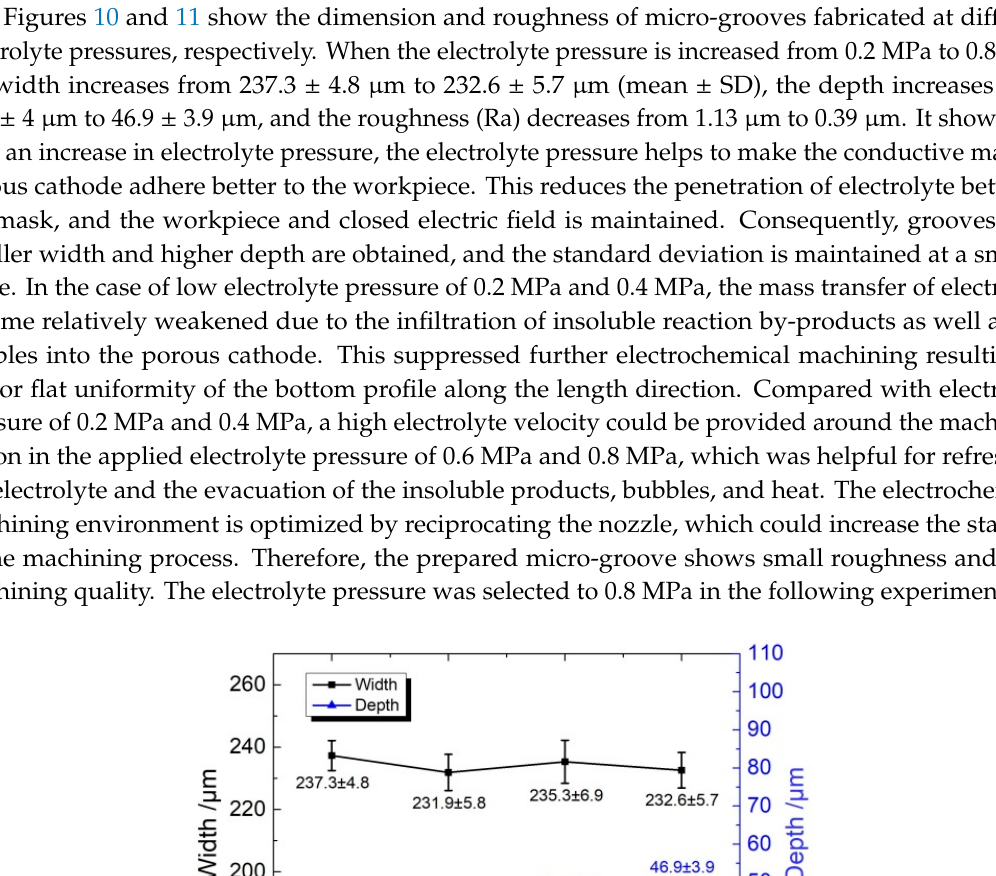
Figure 11. The roughness of micro-grooves generated with different electrolyte pressures ( U = 35 V, ε = 20%, f = 1 kHz, t on = 20 s). 4.3. Micro-Grooves Generated with Different Pulse Duty Cycles Besides the electrolyte pressure, the pulse duty cycle also has a significant effect on the fabrication of micro-grooves. The pulse current is helpful to improve the machining accuracy of ECM and to refresh the electrolyte during the pulse-off time. In the above study, the pulse duty cycle of 20% was utilized. In order to investigate the influence of the pulse duty cycle on the machining process, experiments with different pulse duty cycles were conducted at a voltage of 35 V. Figure 12 shows the dimensions of the micro-grooves fabricated with different pulse duty cycles at a frequency of 1 kHz and for the same machining time of 20 s. It can be seen that there is an obvious change in the width of the micro-grooves with an increasing pulse duty cycle. The width increases from 232.6 ± 5.7 μ m to 274.1 ± 12.5 μ m when the pulse duty cycle increases from 20% to 80%. On the other hand, the depth of the micro-groove showed a slight change from 46.9 ± 3.9 μ m to 53.9 ± 4.1 μ m. As we know, the electrochemical reactions cause heat generated in the bulk of the electrolyte (Joule heating) during machining. Especially with a conductive mask, there is a larger reaction area than that in insulated mask, and there would be a large amount of heat generated. This heat increases the electrolyte temperature, resulting in a further increase of the electrolyte conductivity. In the pulse current, the pulse-off time is used to flush the heat and by-products out of the machining gap as well as renew the electrolyte. Consequently, the influence of heat on the machining process is reduced. When the pulse duty cycle is increased, the pulse-off time is reduced. As a result, the heat transport process in the machining gap is weakened, which increases the